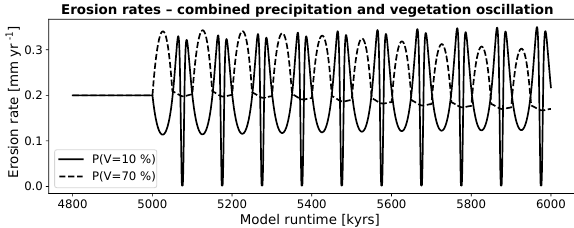
Figure 16. Mean catchment erosion rates for coupled simulations with changes in surface vegetation cover and mean annual precip- itation. The first cycle in the time series is expanded in Fig. 17. The variable amplitude and nonlinear response shown here is due to the combined nonlinear forcings in precipitation (Figs. 4, 5) and rock erodibility and diffusivity (Fig. 6) for different initial vegeta- tion cover amounts.